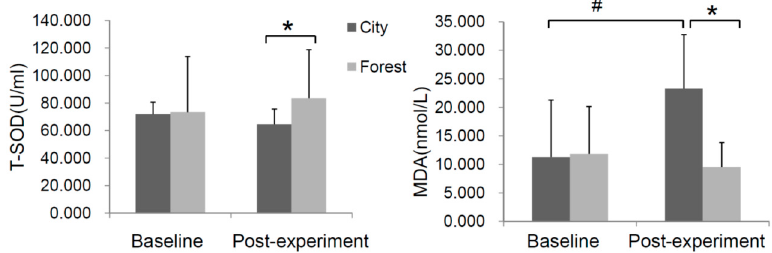
Figure 6. Effect of forest bathing on human oxidative stress alteration reflected by total superoxide dismutase (T-SOD) activity and malondialdehyde (MDA) level in the experimental subjects (forest group ( n = 23) and control group ( n = 10). * p < 0.05; # p < 0.05, analyzed by the Kruskal-Wallis test followed by the Dunn-Bonferroni test.